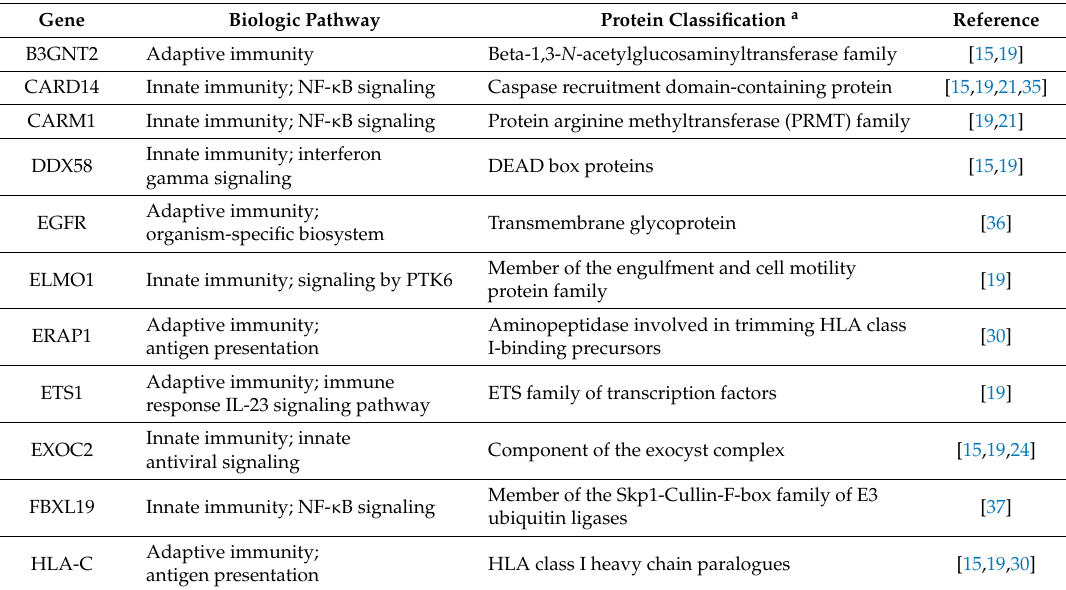
Table 1. Genes associated with the immunogenetics of